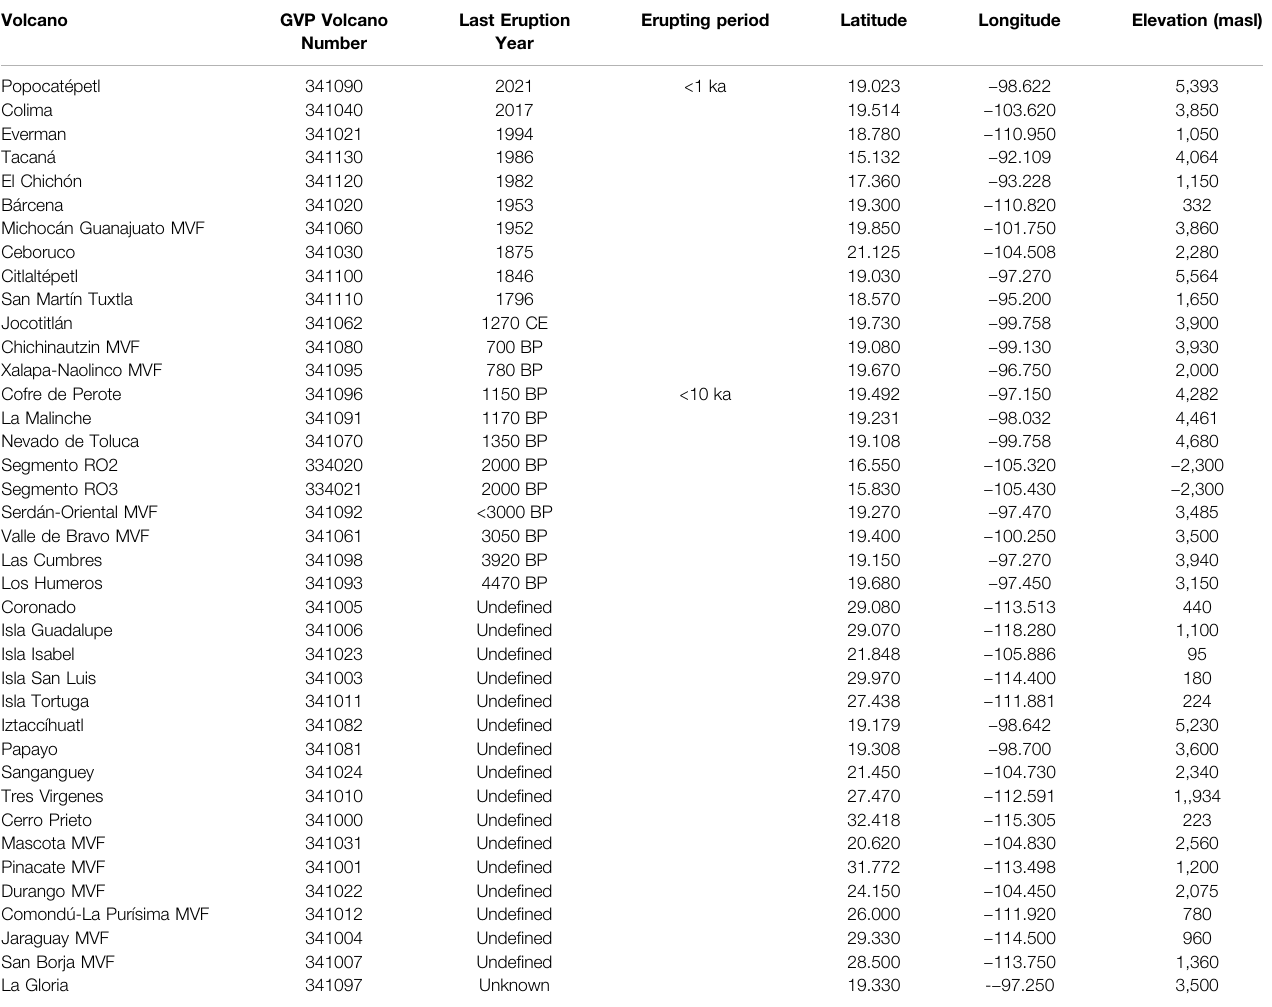
TABLE 5 | List of the 39 Mexican volcanoes ranked in this study. 13 volcanoes with an eruption < 1 ka and 26 having erupted < 10 ka Volcano GVP Volcano Last Eruption Erupting period Number Year